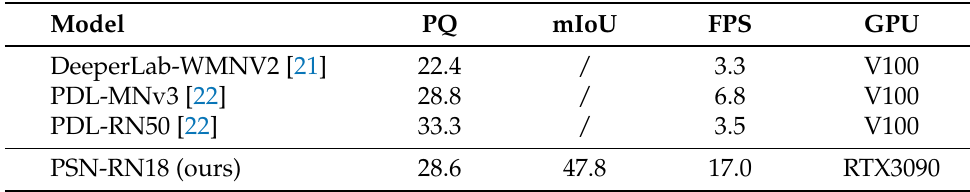
Table 5. Panoptic segmentation performance of pyramidal fusion model on Mapillary Vistas val. We report average FPS over all validation